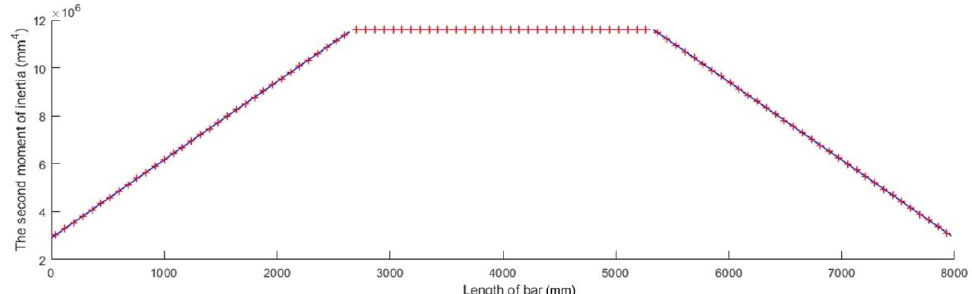
Figure 11. Trapezoidal variation in the second moment of inertia along the bar axis.